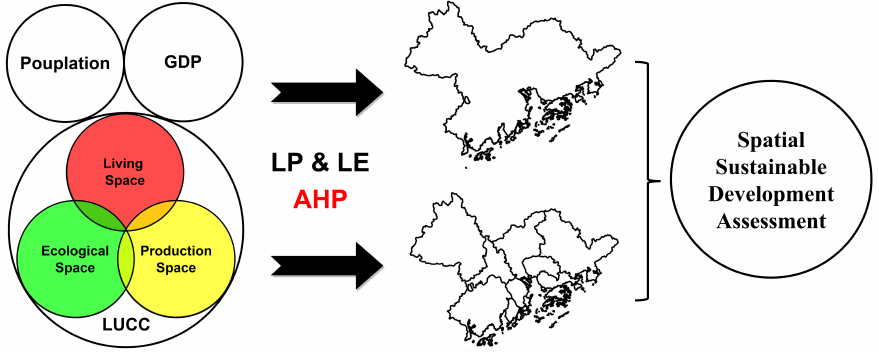
Figure 1. Space Sustainability Assessment